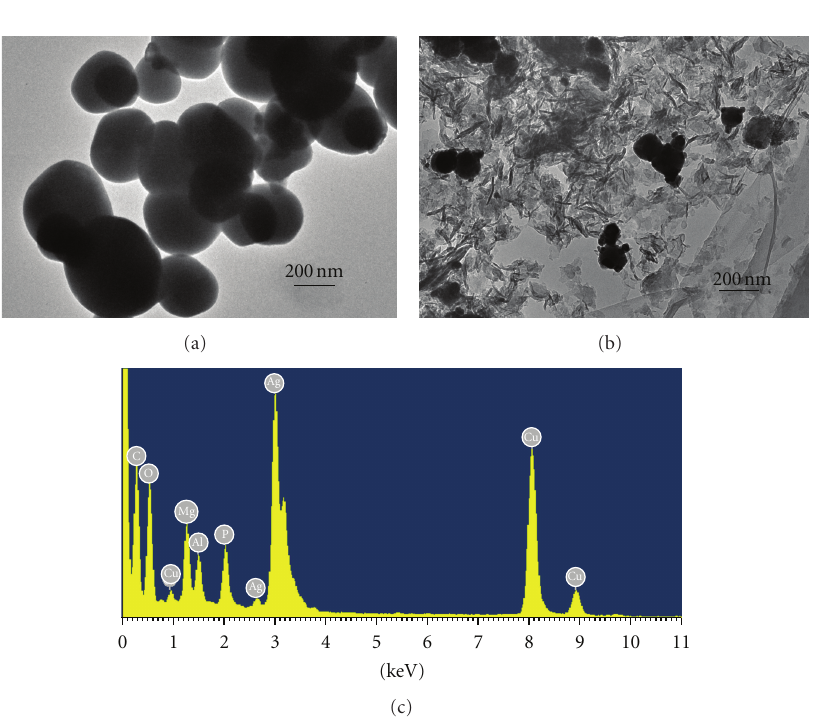
Figure 4: TEM images of Ag 3 PO 4 (a) and Ag 3 PO 4 /FLDH-3 (b), and EDS elemental microanalysis of Ag 3 PO 4 /FLDH-3